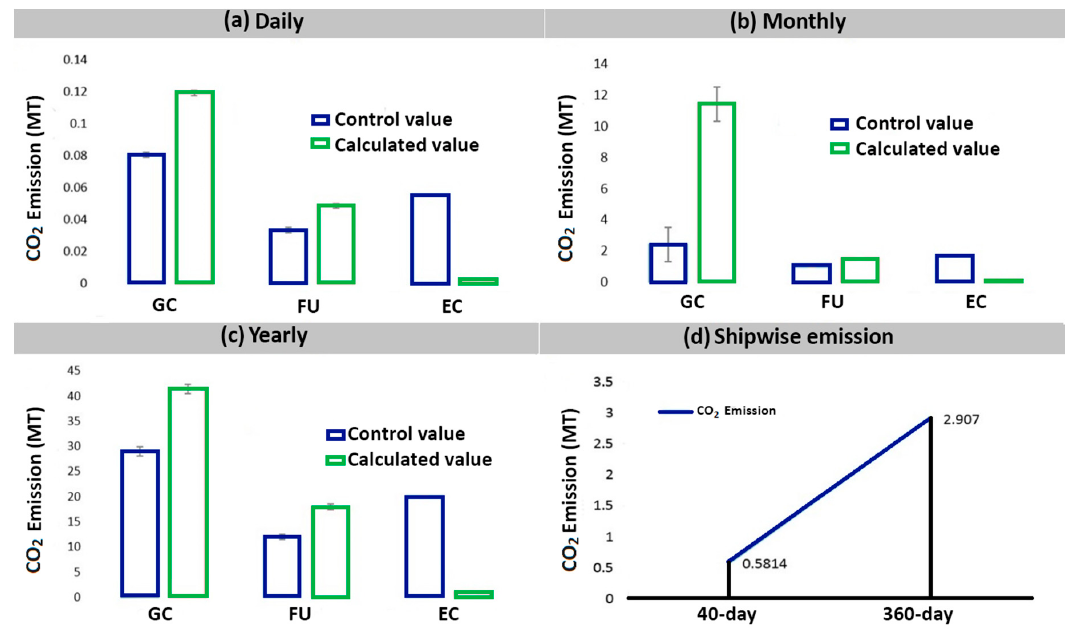
Figure 2. Variations of ( a ) daily, ( b ) monthly and ( c ) yearly CO 2 emissions from gas cutters, diesel and electricity consumption in shipbreaking yards ( n = 15) compared to the control value (10 2 ). Bars indicate standard deviation (SD). ( d ) Ship-wise ( n = 9) CO 2 emission in a particular time period. Here, GC = gas cutter, FU = fuel use and EC = electricity consumption. Environments 2020 , 7 , x FOR PEER REVIEW